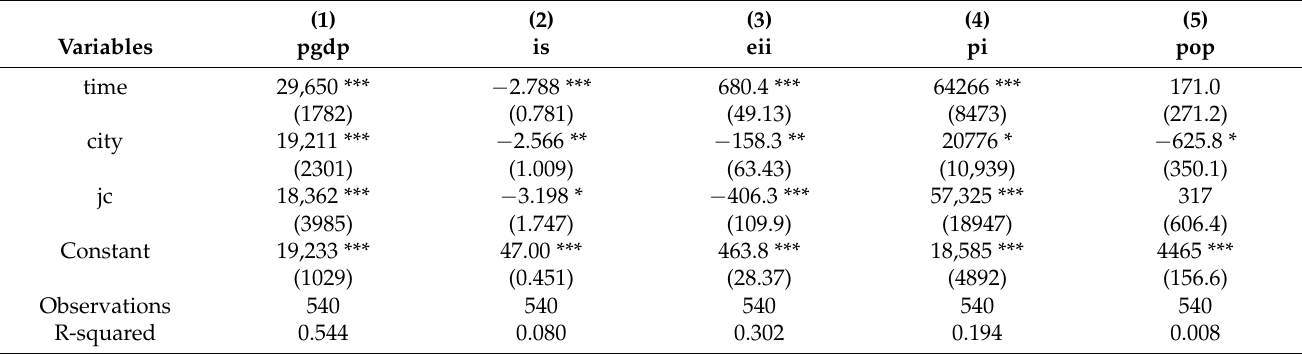
Table 8. Mechanism test of carbon trading policies affecting green economic